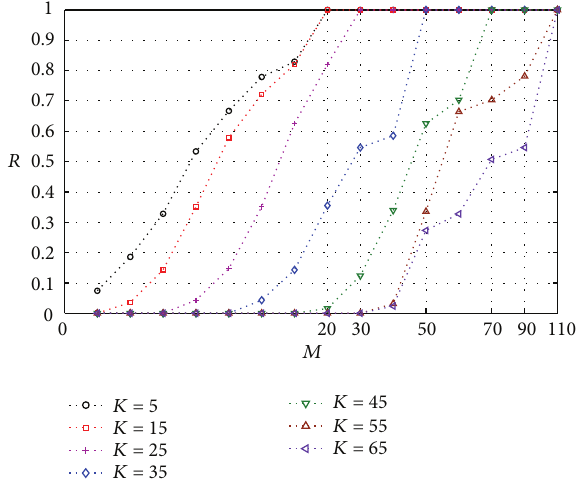
Figure 9: Variation trend between the sparsity 𝐾 and measurement number 𝑀